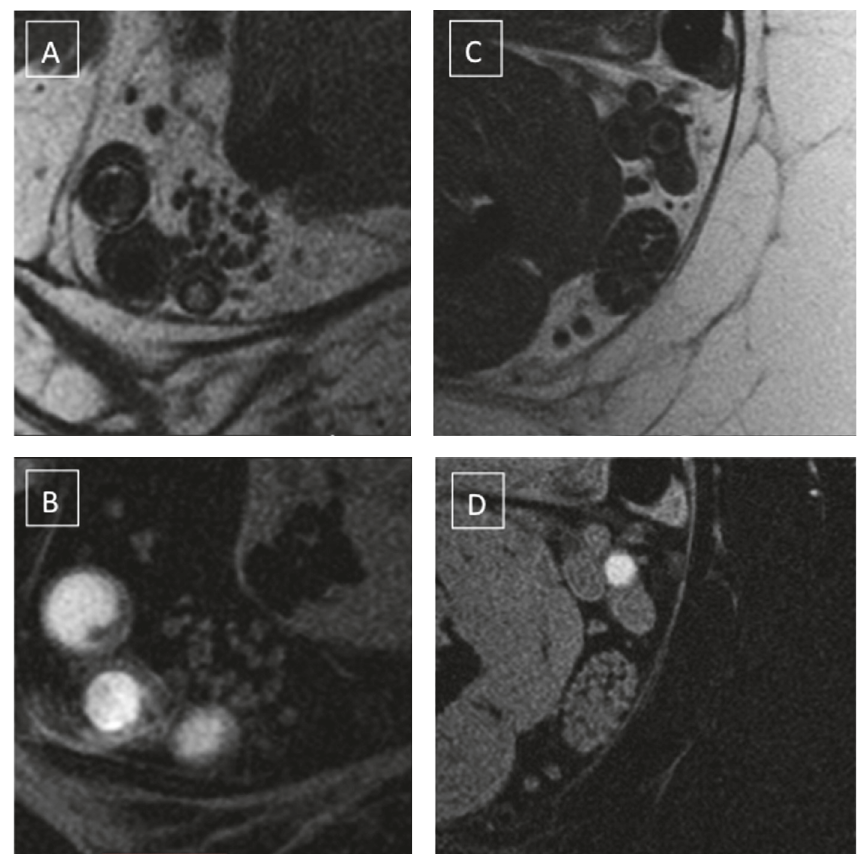
Figure 3: Tibial nerve with chronic degenerative changes (left (A, B)) compared with a volunteer (right (C, D)). The patient was in the group of the moderate/severe DPN and suffered from chronic pain and severe motor impairment. (A, C) Sequence: TSE T1. (B, D) Sequence: IDEAL-WATER. There is a visual increase of the interfascicular tissue (epineurium), while the fascicles appear reduced in number and area. Increase of fat and fibrous tissue within the epineurium is common in chronic stage of diabetic